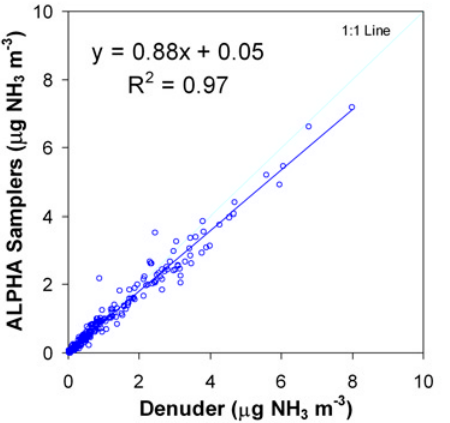
FIGURE 7 . Comparison of individual monthly NH 3 concentrations from triplicate ALPHA samplers operated alongside an active denuder system, as part of the ongoing methods validation at 9 sites in the DETR U.K. National Ammonia Monitoring